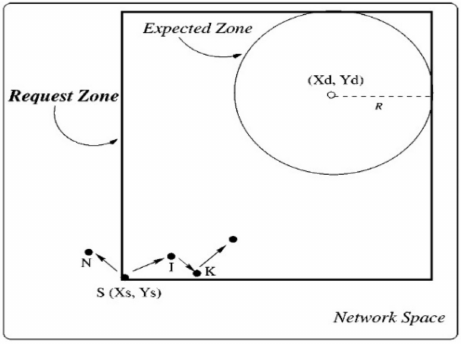
Figure 5. The expected and request